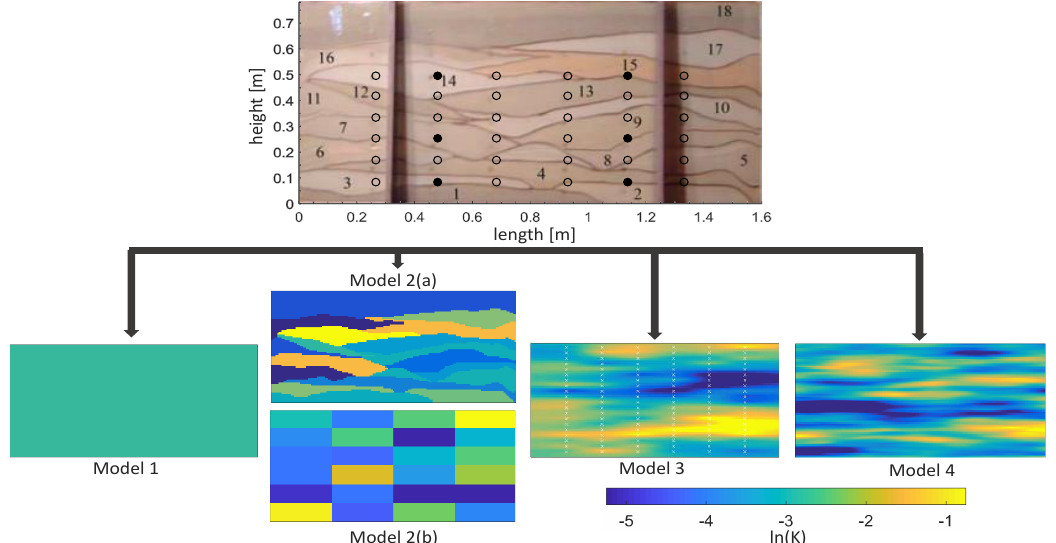
Figure 2. Top : Photograph of the laboratory sandbox aquifer (modified from [33]). The different coloured layers resemble different hydraulic conductivities, numbers enumerate the layers. Circles indicate the locations of the ports, pumping ports are marked by black dots. Bottom : Corresponding numeric models (modified from [15]): Homogeneous (1), informed zonated (2a) and uninformed zonated (2b), pilot-point-based (3) and geostatistical